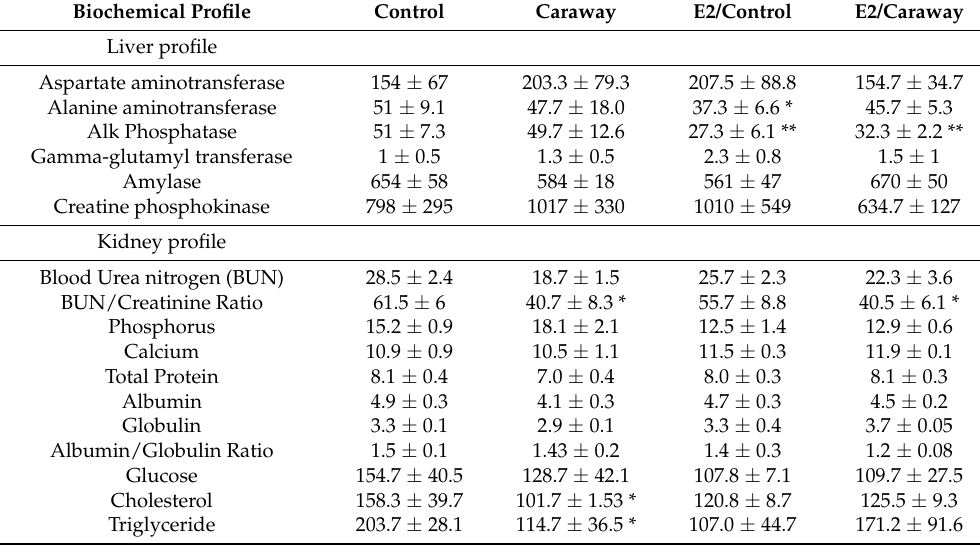
Table 2. The effects of E2 exposure and caraway supplemented diet (7.5%) on biochemical profiles (systemic toxicity) at the tumor time point in ACI rats.